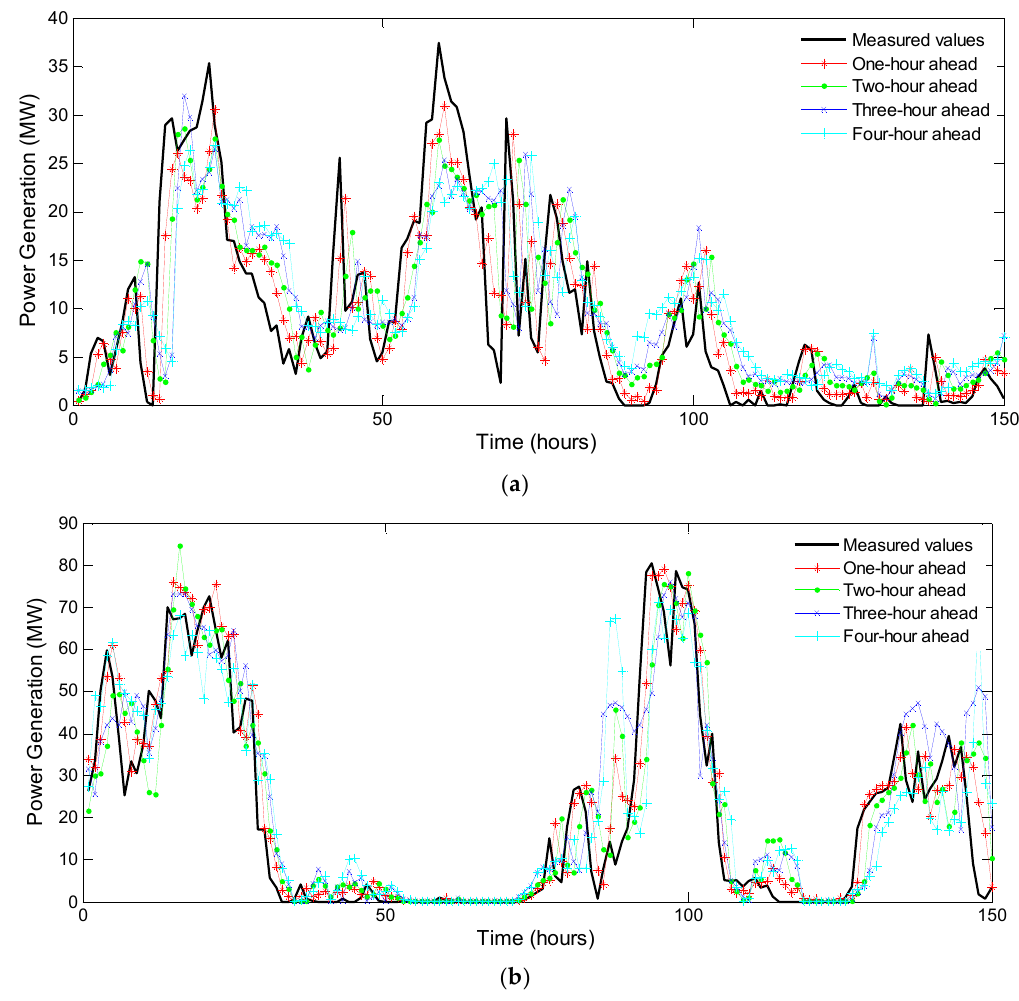
Figure 6. Partial results of multi-step ahead prediction in the test month: ( a ) power generation prediction of 150 h in Anzishan wind farm (June 2017); and ( b ) power generation prediction of 150 h in Xuqiao wind farm (December 2017).